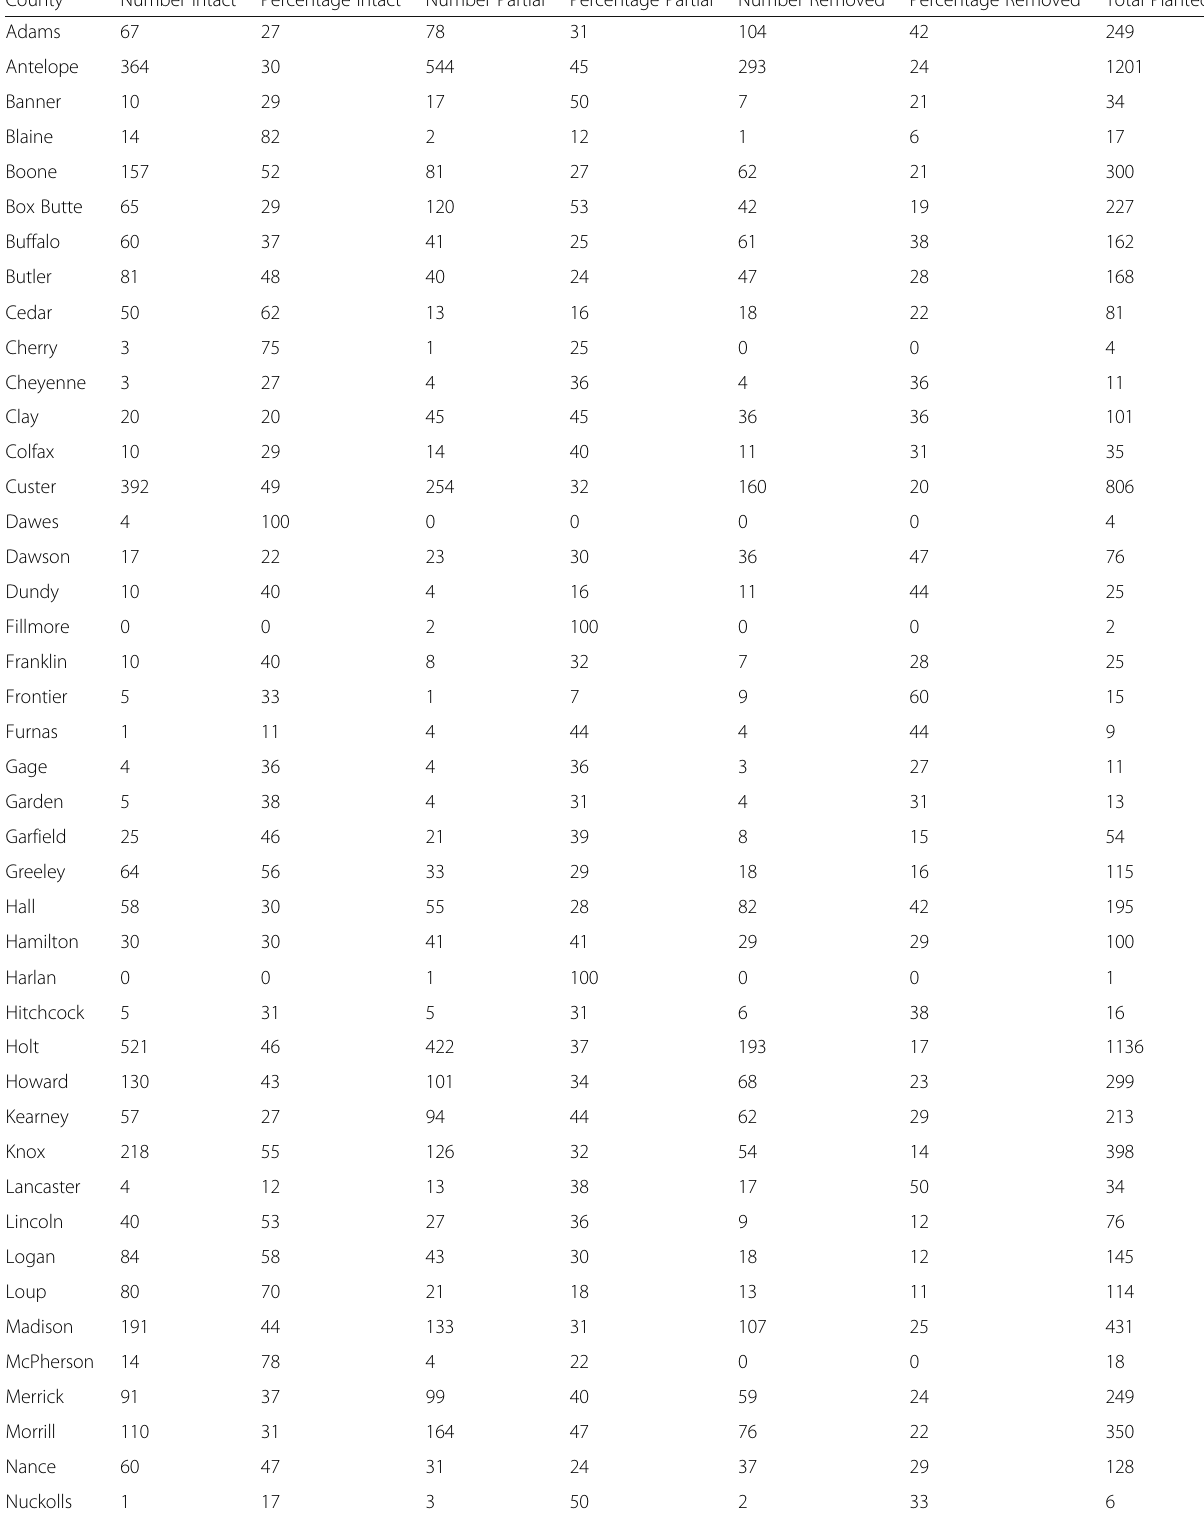
Table 5 2016 inventory and existing condition of Nebraska PSFP (1935 – 1942) in each participating county listed in alphabetical order County